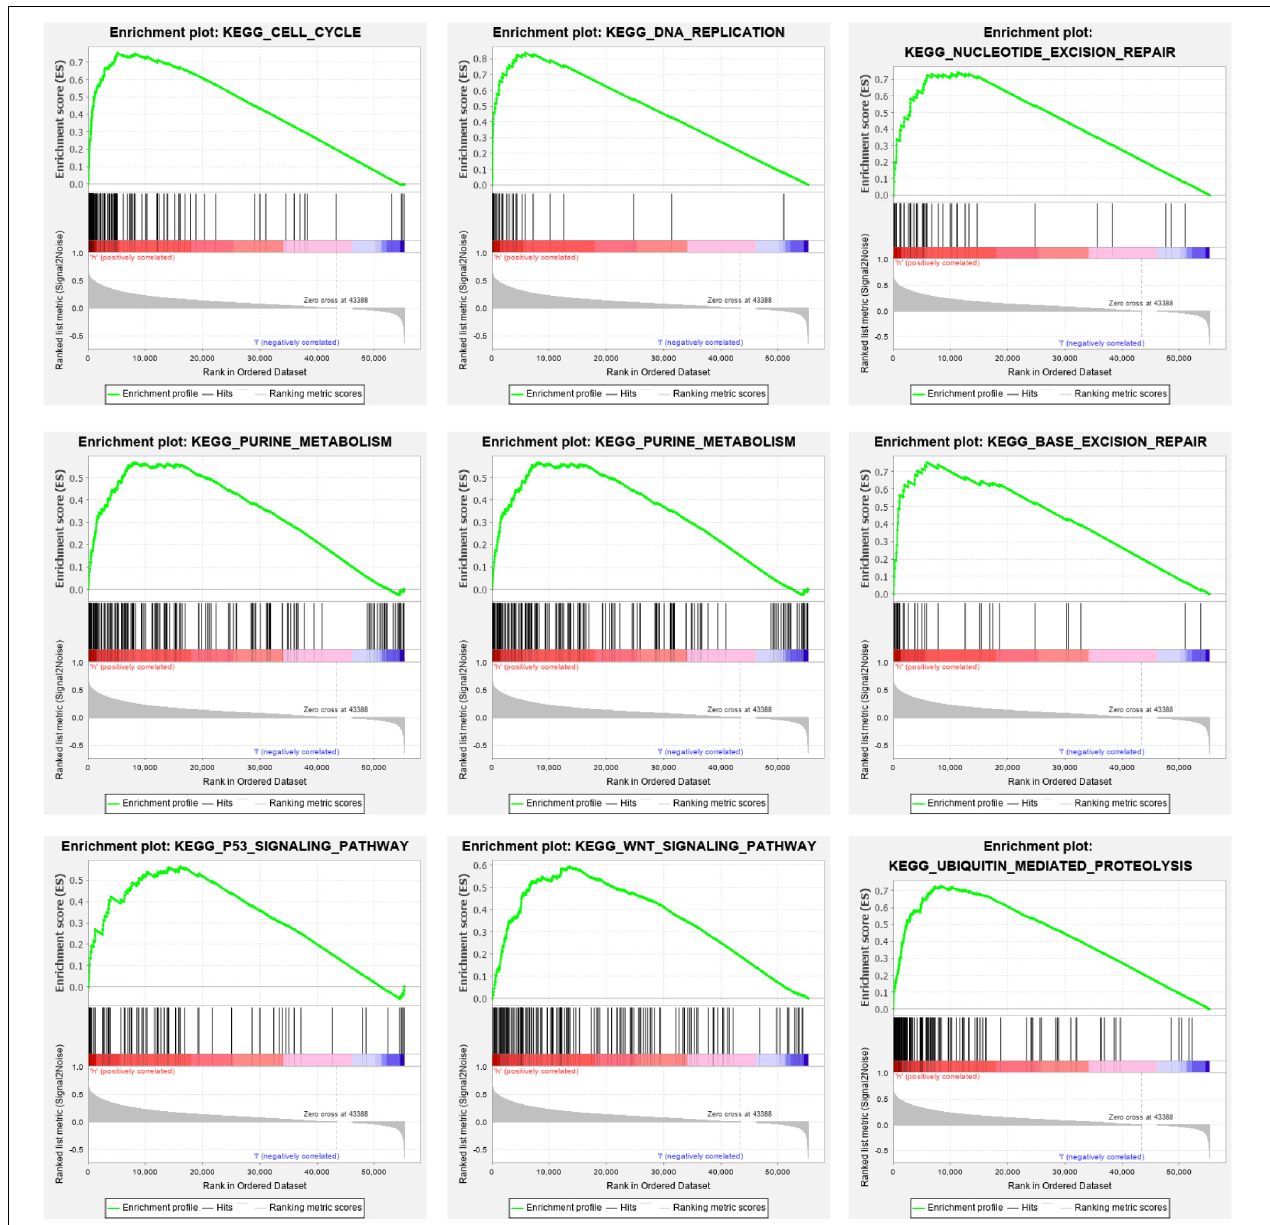
FIGURE 9 | Cellular processes and pathways in LIHC subsets, defined by risk scores. GSEA showed that the low survival subgroup was obviously correlated with processes such as the cell cycle, DNA replication, WNT signal pathway, and protein degradation. GSEA, Gene Set Enrichment Analysis; LIHC, liver hepatocellular